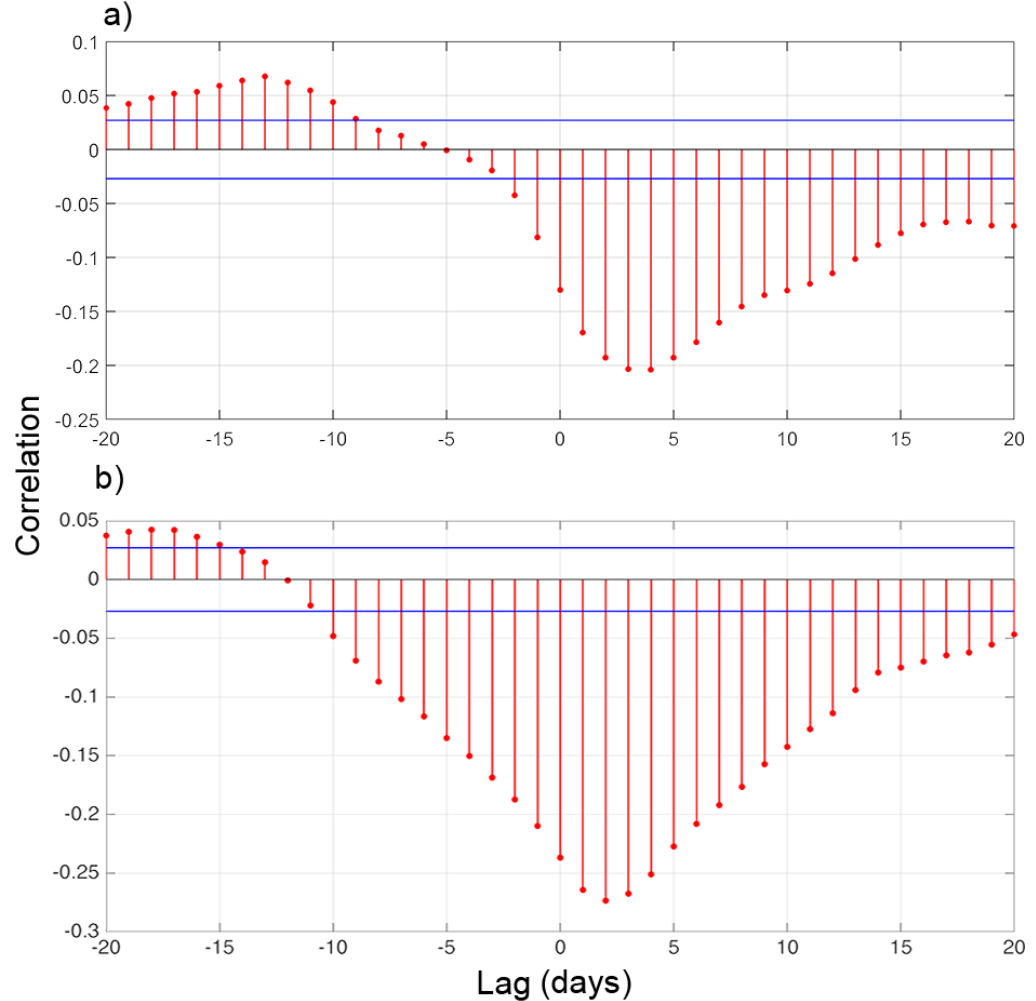
Figure 9. Cross-correlation between daily SST anomalies and daily alongshore SSW anomalies ( a ) and daily SST anomalies and daily Chl-a anomalies ( b ). SST and Chl-a correspond to north of the Punta Galera (~39.25 ◦ S, Figure 3, rectangle white 1) and alongshore SSW correspond to the area closest to Punta Galera (~40 ◦ S, Figure 3, rectangle white 2). The blue lines in (a,b) shows the upper and lower confidence bound (95% confidence